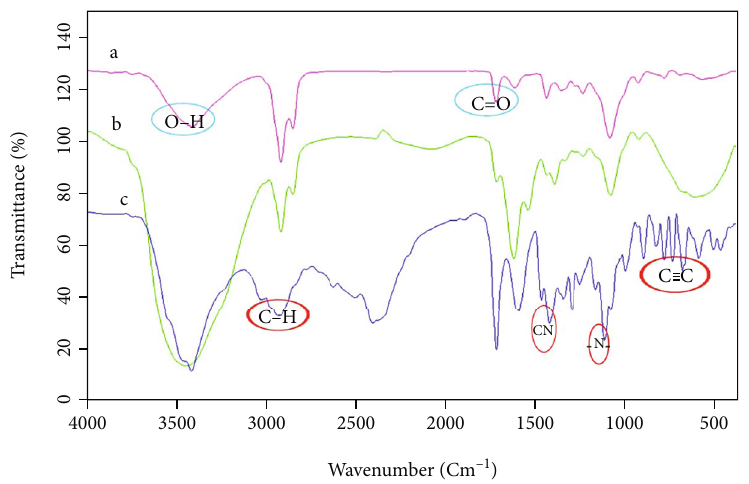
Figure 3: The FT-IR spectra of (a) niosomes, (b) niosome-selegiline, and (c)